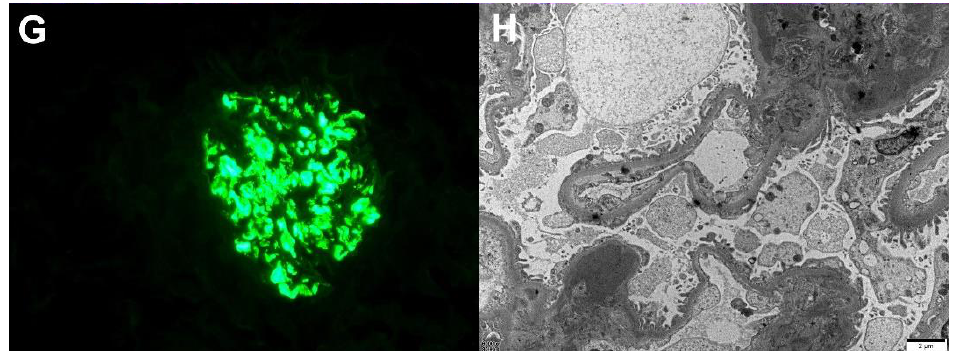
Figure 1. Pathological findings of IgA nephropathy. Light microscopy: ( A ) In low magnification, no tubular atrophy or interstitial fibrosis was present (periodic acid – Schiff, ×40). ( B ) The glomerulus shows mesangial hypercellularity with increased mesangial matrix (periodic acid – Schiff, ×400). ( C ) The glomerulus shows endocapillary hypercellularity with focal loss of capillary penetrations (periodic acid methenamine silver, ×400). ( D ) The glomerulus shows segmental glomerulosclerosis (Masson’s trichrome, ×400). ( E ) The glomerulus shows cellular crescent with endocapillary hypercellularity (periodic acid – Schiff, ×400). ( F ) The picture shows protein reabsorption vacuoles in tubules, which is evidence of proteinuria (periodic acid – Schiff, ×400). Immunofluorescence: ( G ) Strong IgA mesangial positivity in the immunofluorescence stain (×400). Electron microscopy: ( H ) Numerous large electron-dense deposits in the mesangial areas with focal foot process effacement in the capillary surface were observed (×6000, 80 kv).